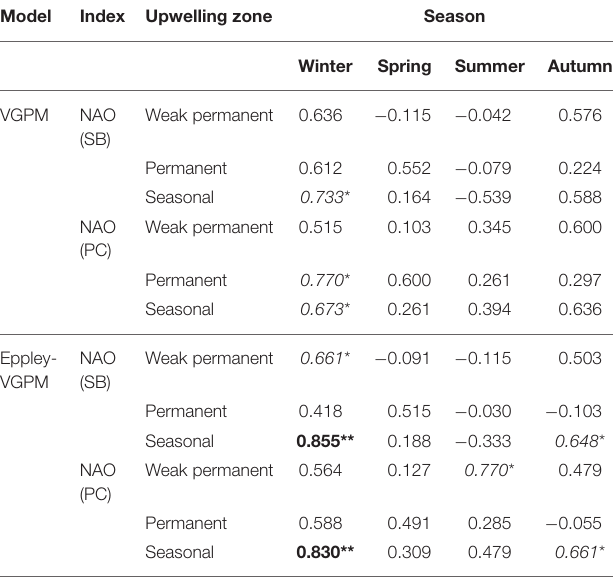
TABLE 3 | Correlations between seasonal selected NPP anomalies and NAO indices (SB, station-based; PC, principal component) with no lag applied for the MODIS dataset (2003–2015).